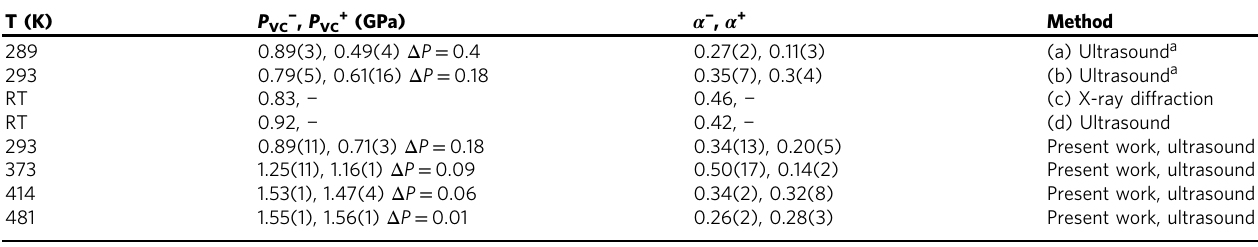
Table 1 Pressure P VC (GPa) and exponent α obtained by fi tting B S ( P ) ~ | P − P VC | α to the data T